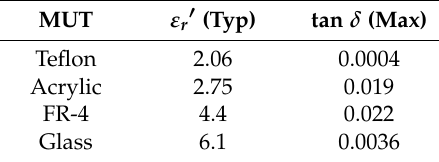
Figure 14. Variation in % relative error of ε r ′. Table 4. Expected values for ε r (cid:48) and tan δ